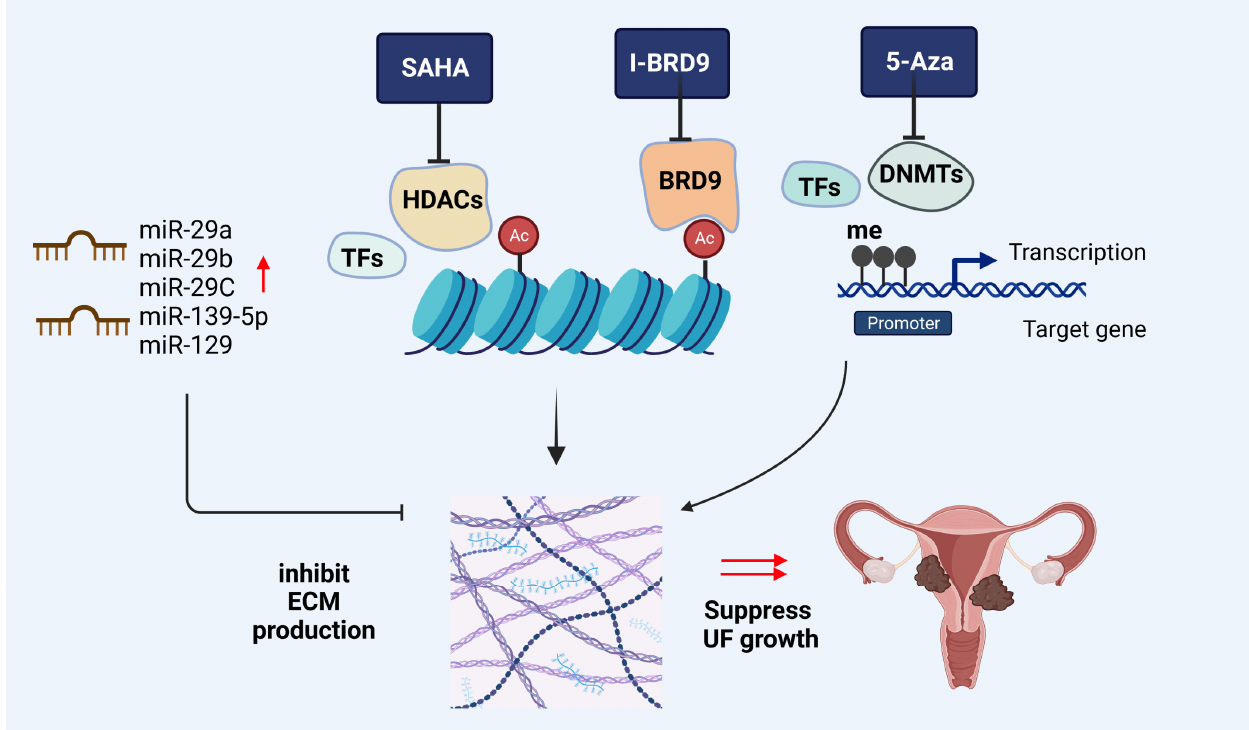
Figure 2. Epigenetic-mediated targeting on ECM production. Targeted inhibition of HDACs, BRDs, and DNMTs and overexpression of targeted microRNAs can decrease the ECM deposition and accumulation in UF cells, leading to inhibited UF growth. Red up-arrow: overexpression of the microRNAs, which lead to the inhibition of ECM production; black ⊥ : inhibition ; HDACs: histone deacetylases; BRD9: bromodomain-containing protein 9; DNMTs: DNA methyltransferases; ECM: extracellular matrix; TFs: transcription factors; SAHA: suberoylanilide hydroxamic acid (HDAC inhibitor); I-BRD9: BRD9 inhibitor; 5-Aza: 5-Aza-2-deoxycytidine (DNMT inhibitor). This figure was created using BioRender software.